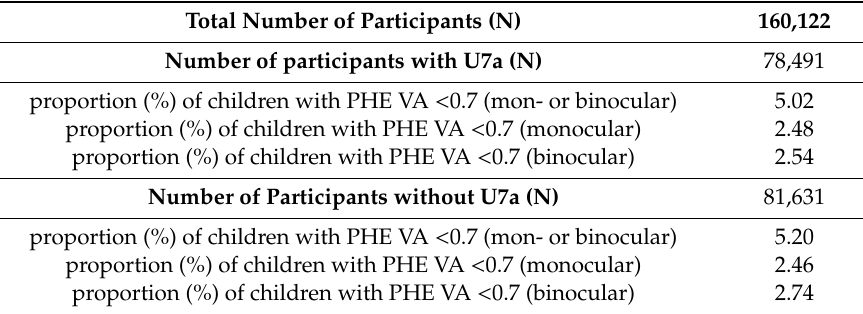
Table 2. Proportion of children with reduced VA at